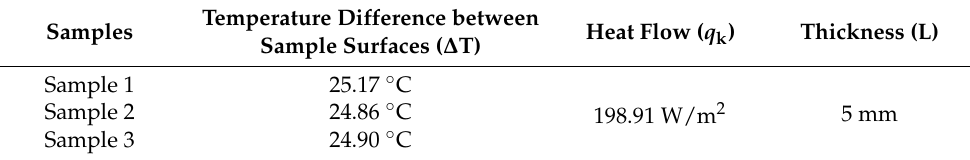
Table 5. Variables for measuring thermal conductivity for Buriti foam samples.